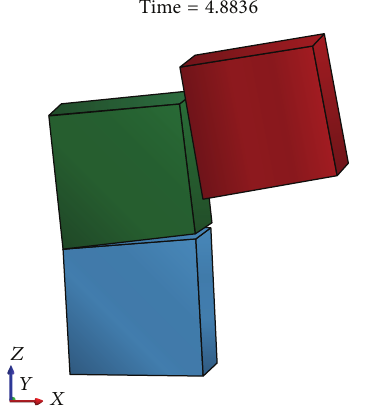
Figure 6: Block impact under breakaway conditions in (1) (4.8 sec).